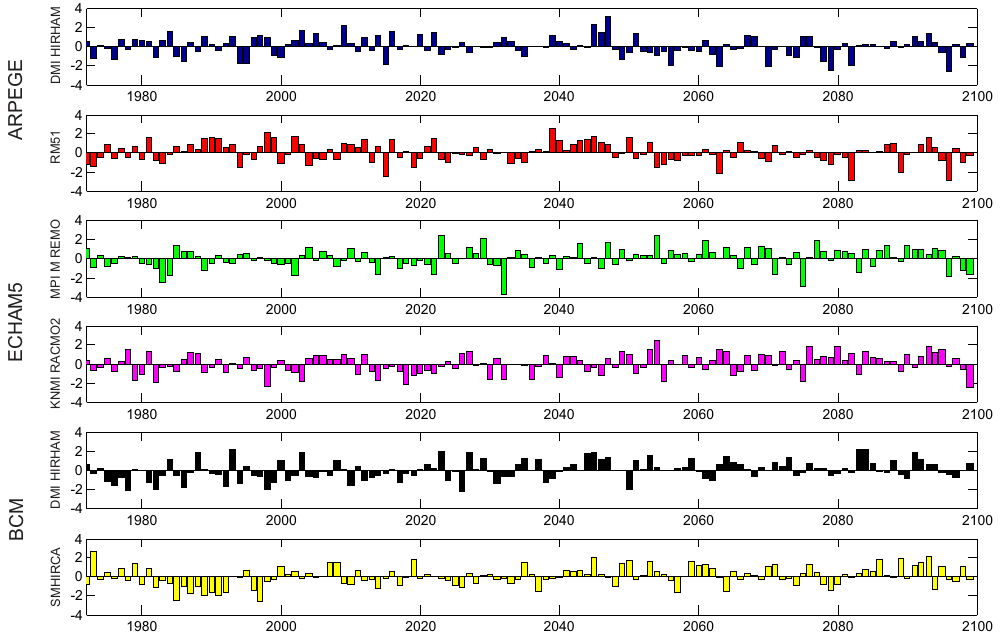
Figure 7. An example of SPI 12 time series for raw data: DMI HIRHAM ARPEGE, RM51 ARPEGE, MPI M REMO ECHAM5, KNMI RACMO2 ECHAM5 r3, DMI HIRHAM BCM, SMHIRCA